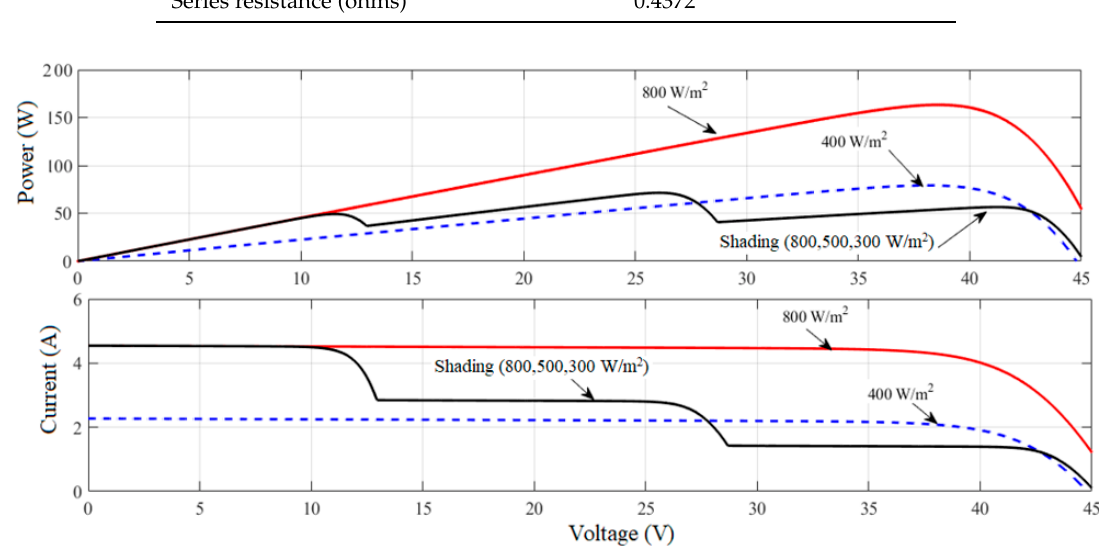
Table 3. Characteristics of PV panel under different conditions.